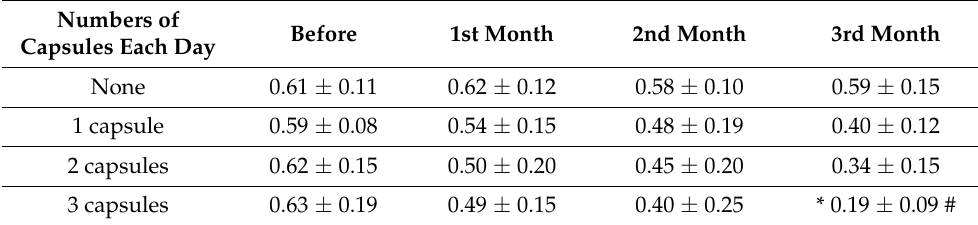
Table 3. The assessments of the patients’ vision before and after taking the mixed fruit enzyme capsules over a three-month period in Experiment